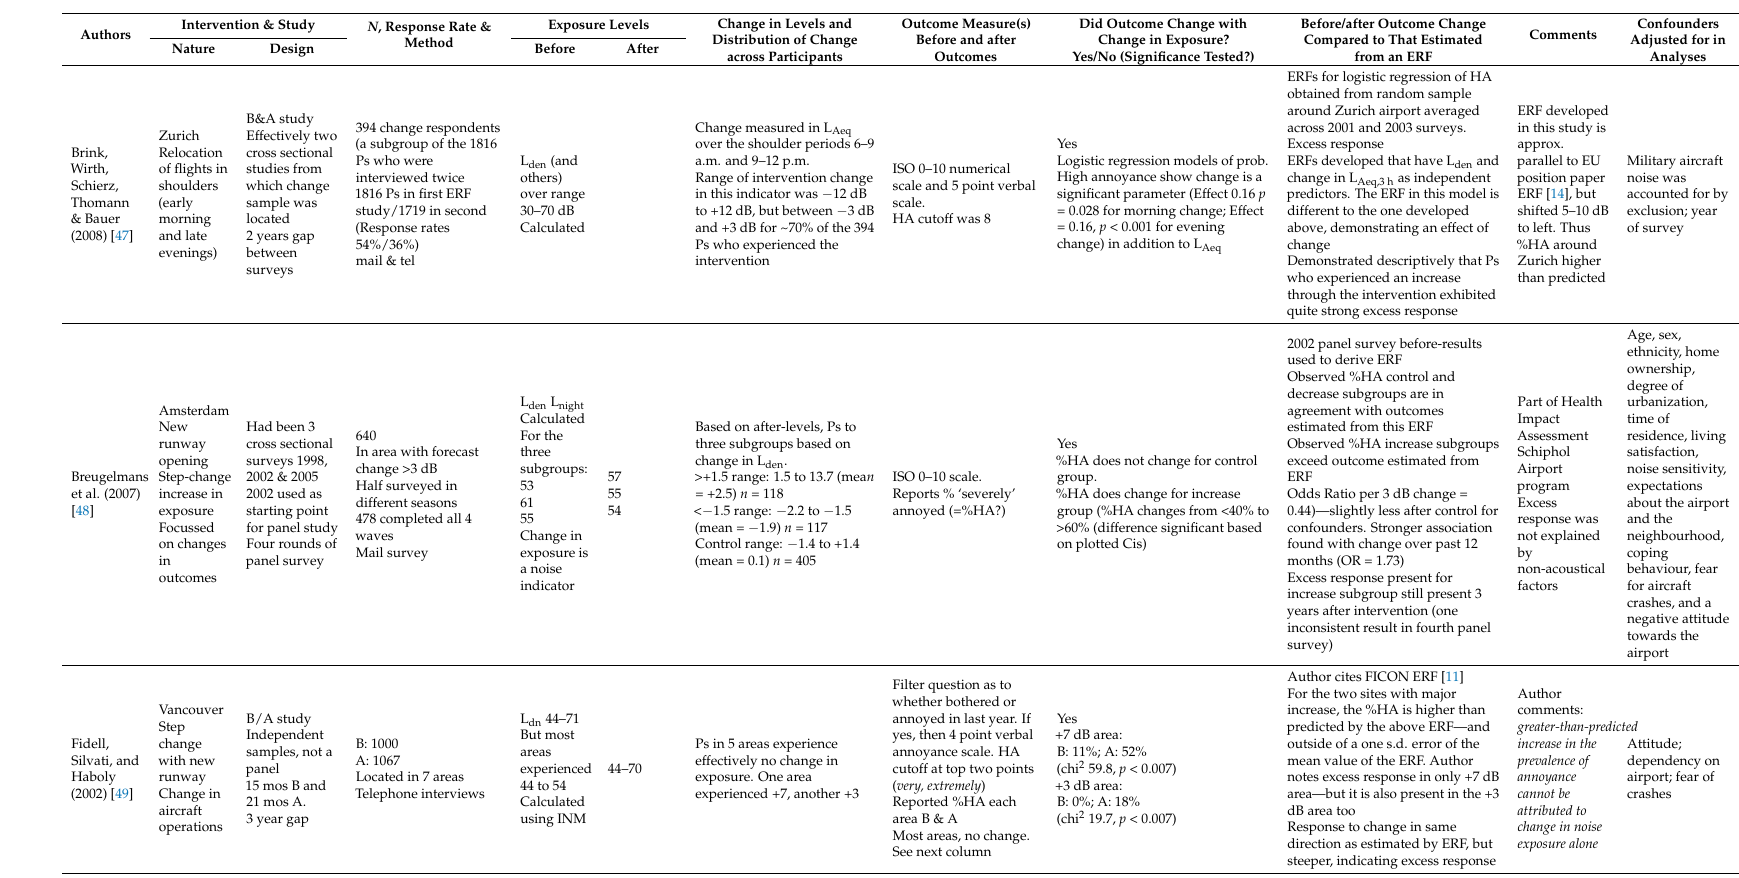
Table 13. New/Closed Infrastructure (Type